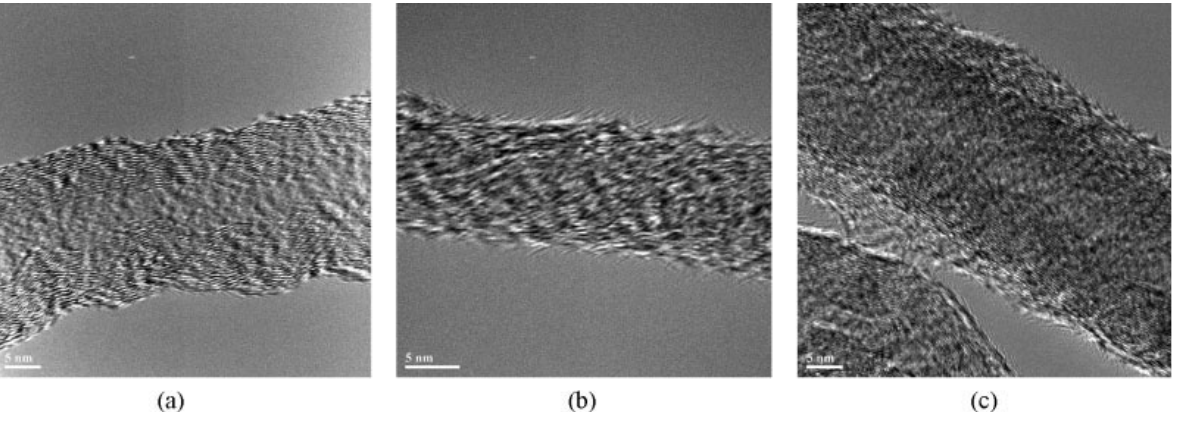
Figure 36. TEM images of (a) the raw MWCNTs, (b) silica-coated MWCNTs, and (c) 3- MPTS functionalized MWCNTs. Reproduced with permission from ref.